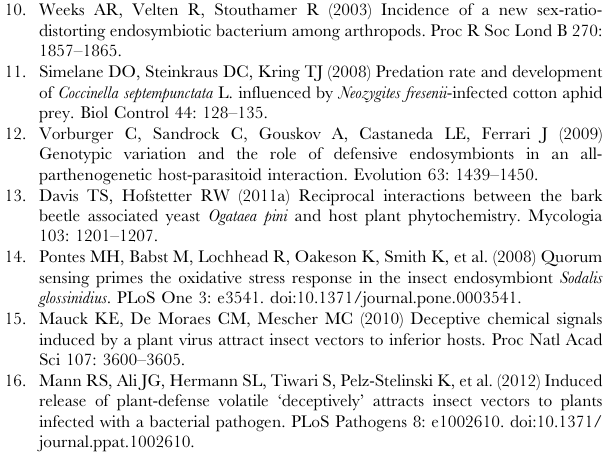
Table S1 Standardized scoring coefficients. The importance of each compound in separating plant headspaces by experimental treatments along discriminant function (DF) axes 1 and 2. Values are dependent variable canonical coefficients, and absolute values rank the weight of each compound in the ordination.